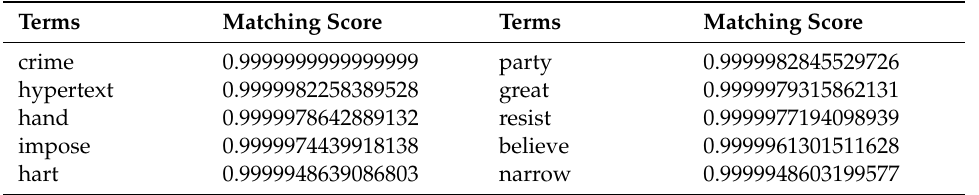
Table 1. Top Terms for the Crime.